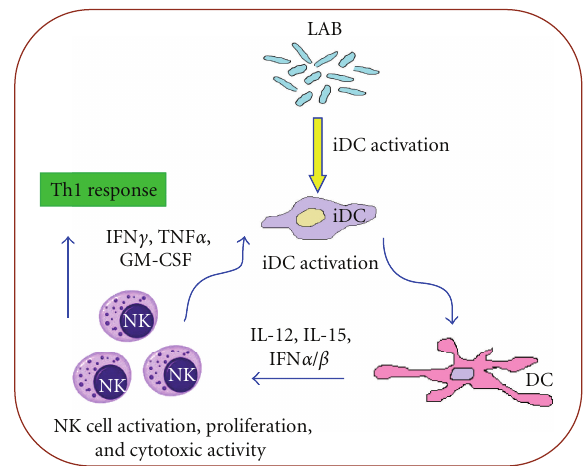
Figure 1: Bi-directional activation between dendritic cell and natural killer (NK) cells in the presence of commensal bacteria. Immature dendritic cells (iDC) are activated and matured by commensal bacteria, for example, lactic acid bacteria (LAB). These LAB-activated mature dendritic cells (DC) produce cytokines able to activate NK cell cytotoxicity and induce their proliferation. Activated NK cells can in turn, via the release of relevant cytokines, recruit (GM-CSF) and activate iDC (TNF- α and IFN- γ ). Alterna- tively, activated NK cells can exert an editing of DC by killing some of the iDC. At the same time, the early release of IFN- γ by NK cells interacting with LAB-activated DC, most likely in secondary lymphoid organs such as the mesenteric lymph nodes, is critical for shaping the following adaptive immune response toward a type 1 T cell response. Remarkably, some LAB display opposite outcomes and could hamper T cell type 1